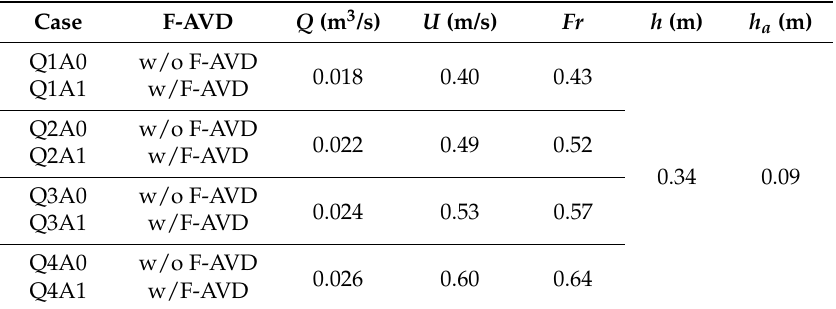
Figure 7. Instantaneous flow visualization at z / h = 0.7 (flow rate— Q = 0.022 m 3 /s): ( a ) without F-AVD and ( b ) with F-AVD. Table 1. Summary of experimental conditions. F-AVD—floating anti-vortex device; Q —flow rate; U —magnitude of inflow velocity; Fr —Froude number; h —water depth; h a — water depth in the approach